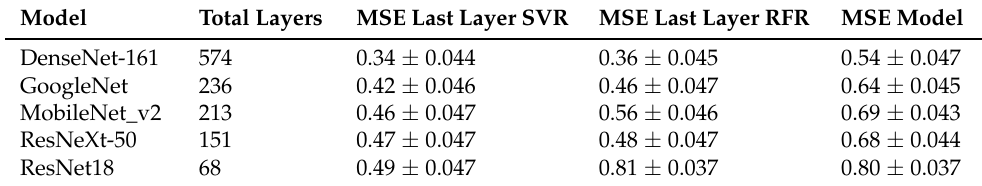
Figure 5. MSE (Mean Square Error) of pain estimation of each model (( a ) GoogleNet, ( b ) MobileNEt, ( c ) ResNet18, ( d ) ResNeXt-50, ( e ) DenseNet-161) and their corresponding 10 layers when used as inputs to SVR and RFR. Table 6. Corresponding MSE of the model and the last layer of each model and total layers.